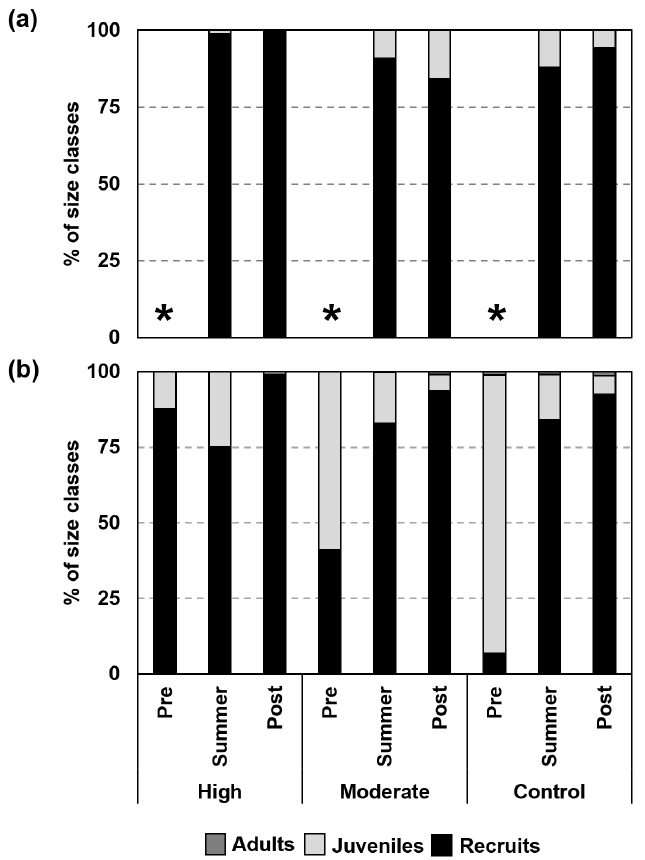
Figure 3. Mean densities + Standard Error of D. hanleyanus and A. mactroides in the distinct sectors for each sampling period. The color bars represent each sector: High Impact (light gray); Moderate Impact (dark gray); and Control (black).